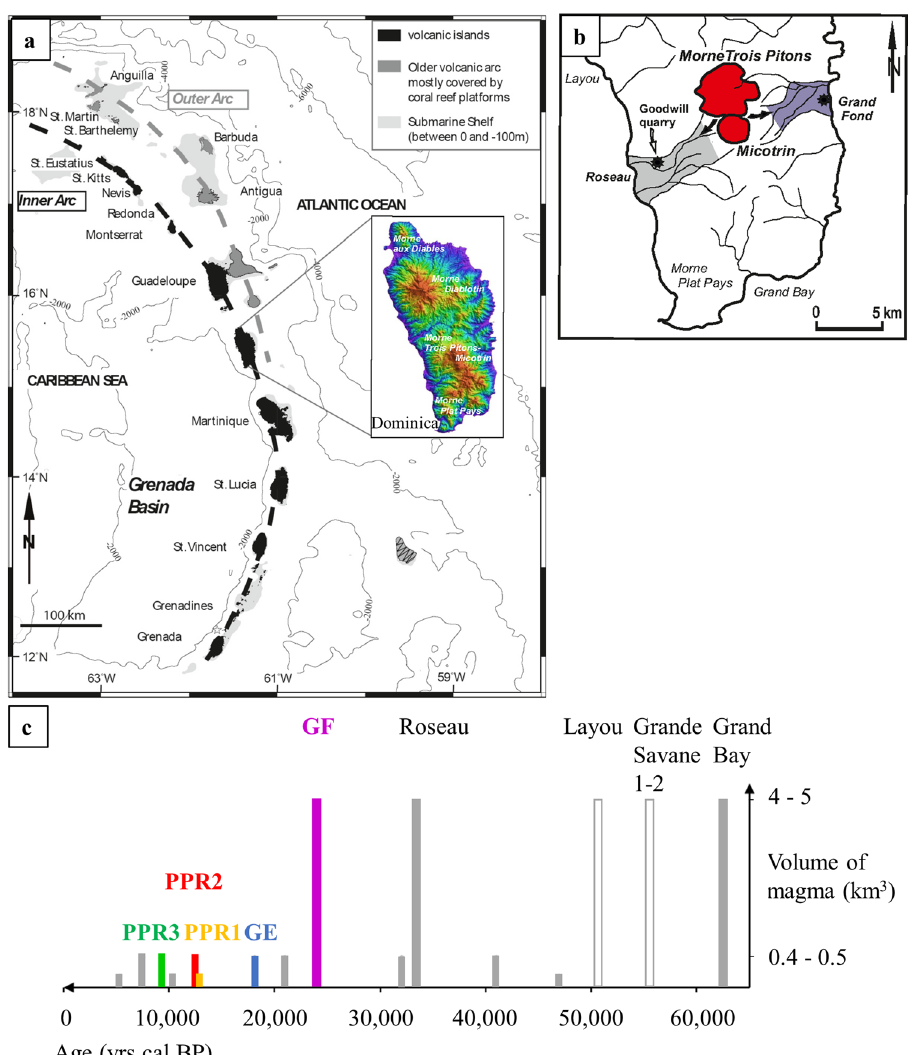
Figure 1. Dominica eruptions. ( a ) The Lesser Antilles arc 60–62 results from the subduction of the northern and southern Atlantic plates beneath the Caribbean plate at a rate of ~ 2 cm/yr 63 . Black: volcanic islands, grey: coral platforms; the map has been modified from a previous study 39 . Bathymetry is in light grey 60 . Inset: Shuttle Radar Topography Mission (SRTM) topography of Dominica with four actives volcanic centers (Morne aux Diables, Morne Diablotins, Morne Trois Pitons-Micotrin and Morne Plat Pays, from north to south) and the largest magmatic production of the Lesser Antilles arc (~ 40 km 3 for the last 100 kyrs) (Courtesy of Dr. Ian C.F. Stewart). ( b ) Map of southern Dominica and location of the studied deposits. From the Morne Trois Pitons-Micotrin volcano, in purple: Grand Fond (GF) large explosive eruption deposits in the valley, outcrop at (15°21 ′ 57 ″ N, 61°15 ′ 16 ″ W, marked by a star on the map) and Goodwill Entrance (GE), PPR1, 2 and 3, in the Roseau Valley (Goodwill quarry: 15°18 ′ 32 ″ N, 61°23 ′ 03 ″ W, star on the map), in grey: Roseau ignimbritic deposits 34 . The maps of ( a , b ) have been done with CorelDraw Graphics Suite 2020 (https:// www. corel draw. com/ fr/). ( c ) Chronology of the pumiceous eruptions from Morne Trois Pitons-Micotrin for 70 kyrs. Rectangles: filled ones: eruptive deposits from Morne Trois Pitons–Micotrin and empty ones: eruptive deposits from Morne Diablotins, their height depends on the magma volume (km 3 ) 34 . Colors: purple for Grand Fond, blue for Goodwill, yellow for PPR1, red for PPR2, green for PPR3 and grey for the unstudied eruptions. The large explosive eruptions involve 4–5 km 3 of magma Dense Rock Equivalent (DRE); the voluminous pyroclastic density currents, which are several tens of meters thick in the main valleys, are more or less welded. The small explosive eruptions involve magma volumes of at least one order of magnitude lower than the large explosive ones 34